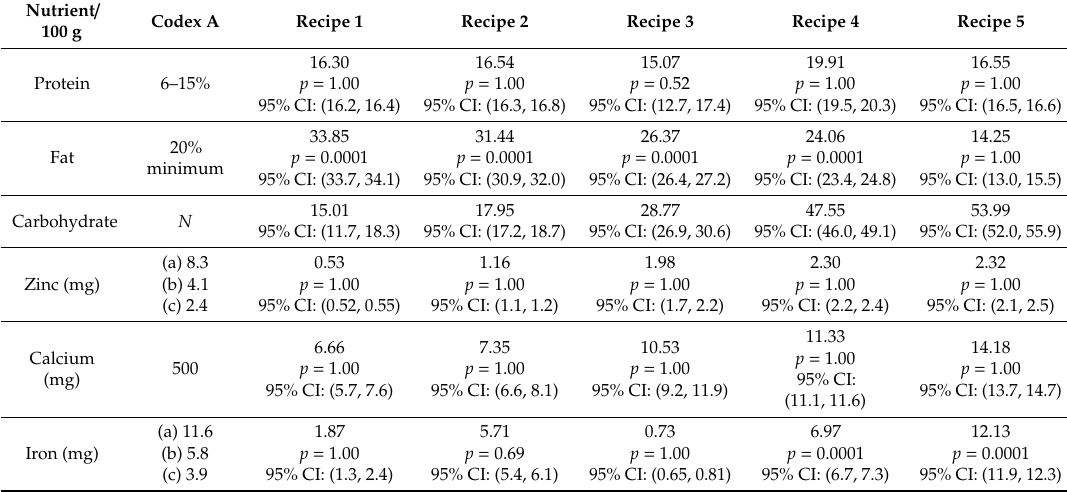
Table 9. Nutrient densities of recipes compared with Codex